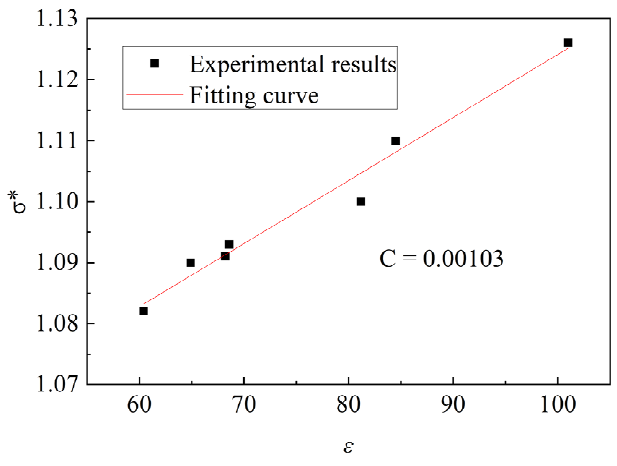
Figure 2. Determination of the strain rate constant.